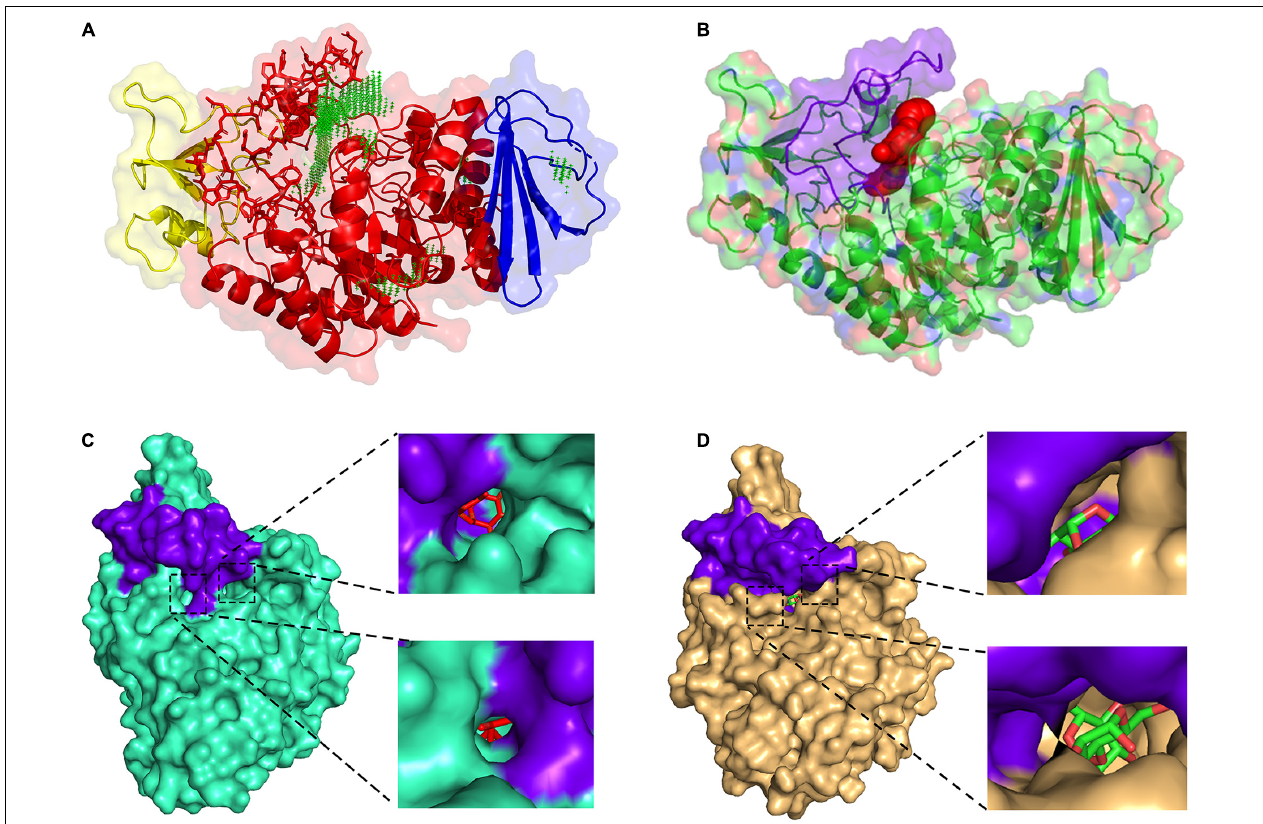
FIGURE 6 | Comparison of the catalytic pocket of QsGH13 and HaG. (A) QsGH13 catalytic pocket prediction result; green represents catalytic pocket. (B) The shape and size of the QsGH13 catalytic pocket. (C) The schematic diagram of the catalytic pocket of HaG. (D) The schematic diagram of the catalytic pocket of QsGH13. Purple represents the β → α loop 4 region; on the left is the overall schematic diagram of the protein catalytic pocket, the upper right is the right view of the catalytic pocket, and the lower right is the left view of the catalytic